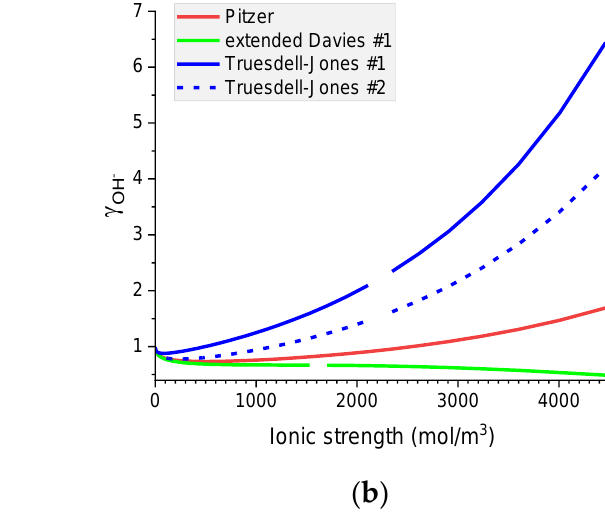
Figure 7. Molar OH − individual activity coefficients in aqueous ( a ) NaOH and ( b ) KOH solutions. Comparison of calculated activity coefficients based on the Pitzer, extended Davies, and Truesdell–Jones models at 25 °C.